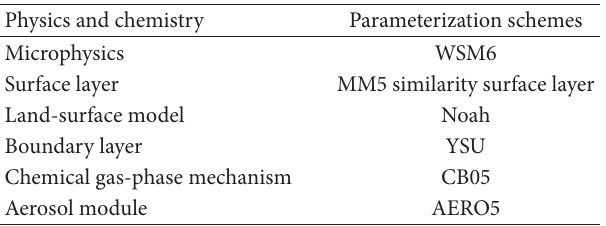
Table 1: A summary of configurations used in the WRF-CMAQ